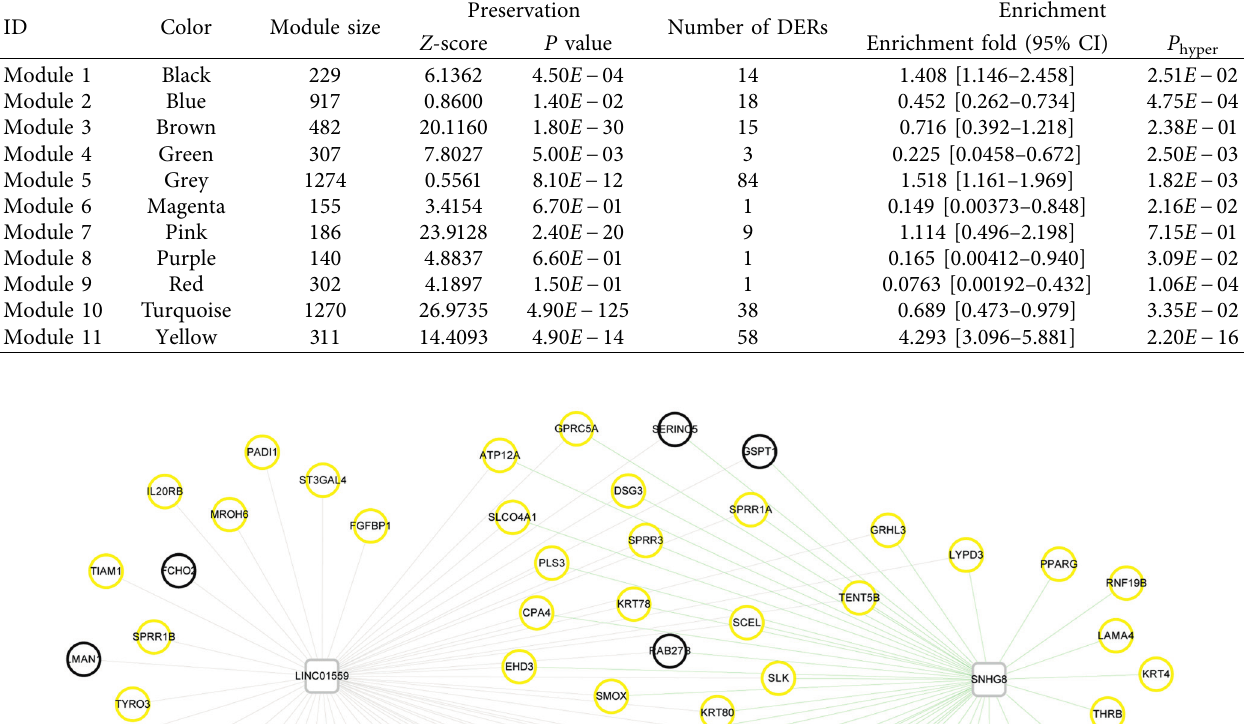
Table 1: Evaluation of each module identified by WGCNA and the module information obtained by hypergeometric algorithm.